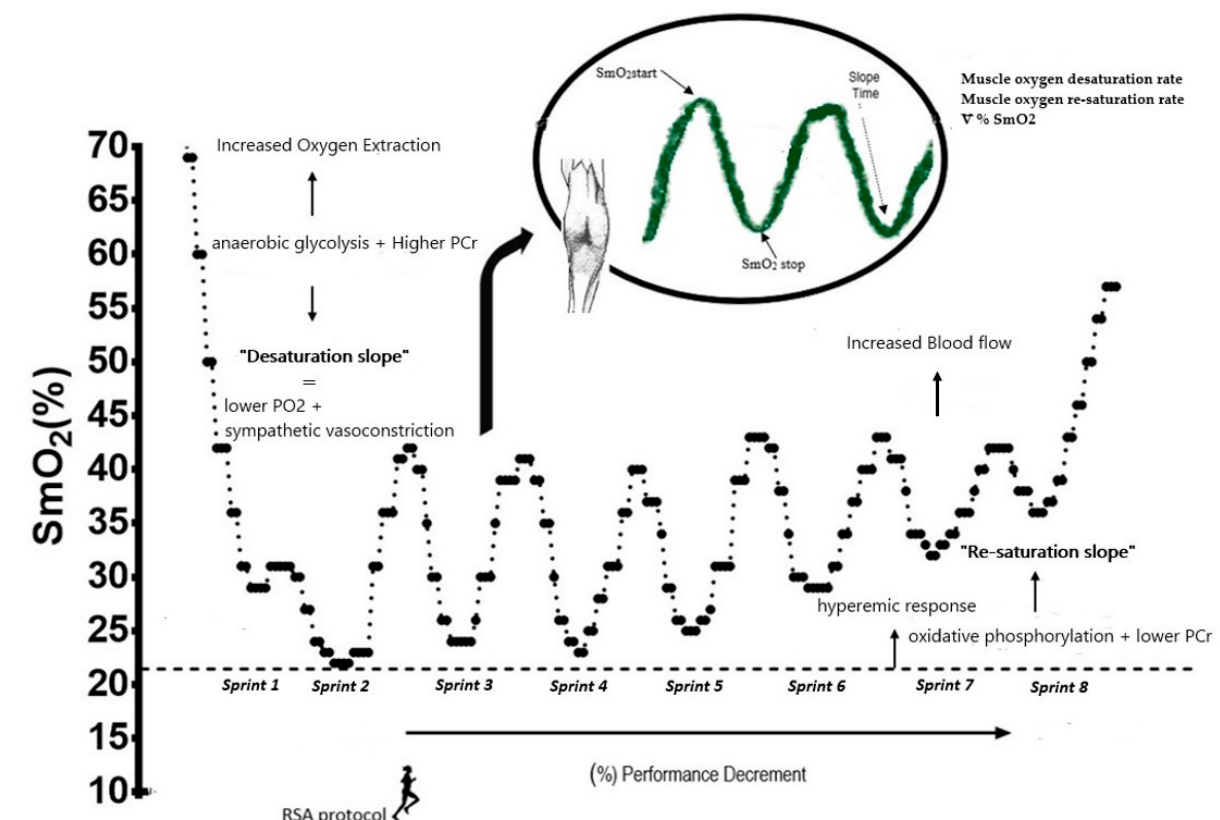
Figure 2. Example of the analysis and interpretation of desaturation and re-saturation muscle capacity during the sprinting exercise.